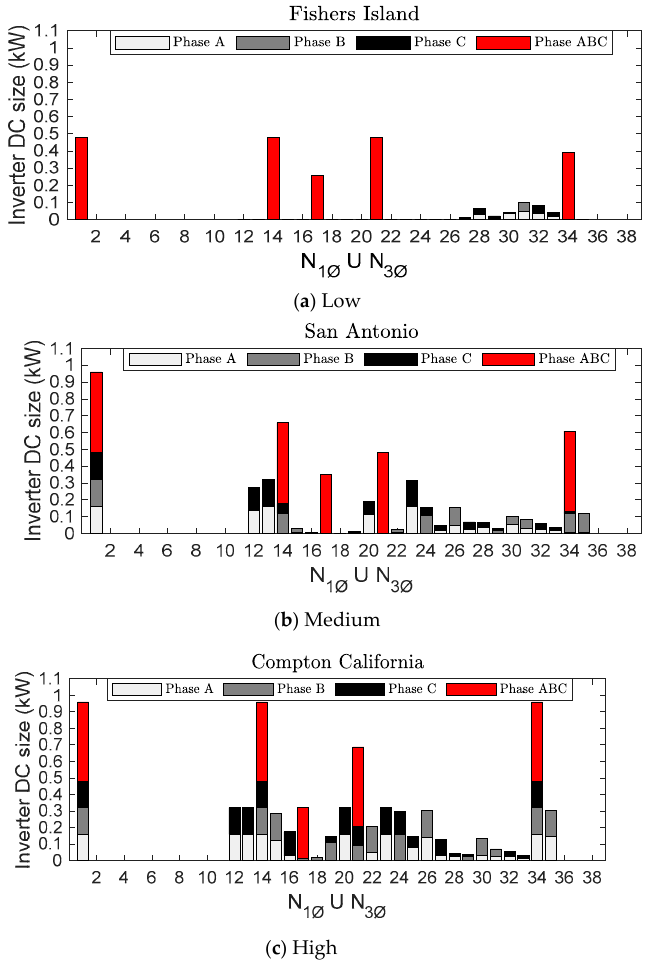
Figure 3. PV inverter placement and size at the base load condition.